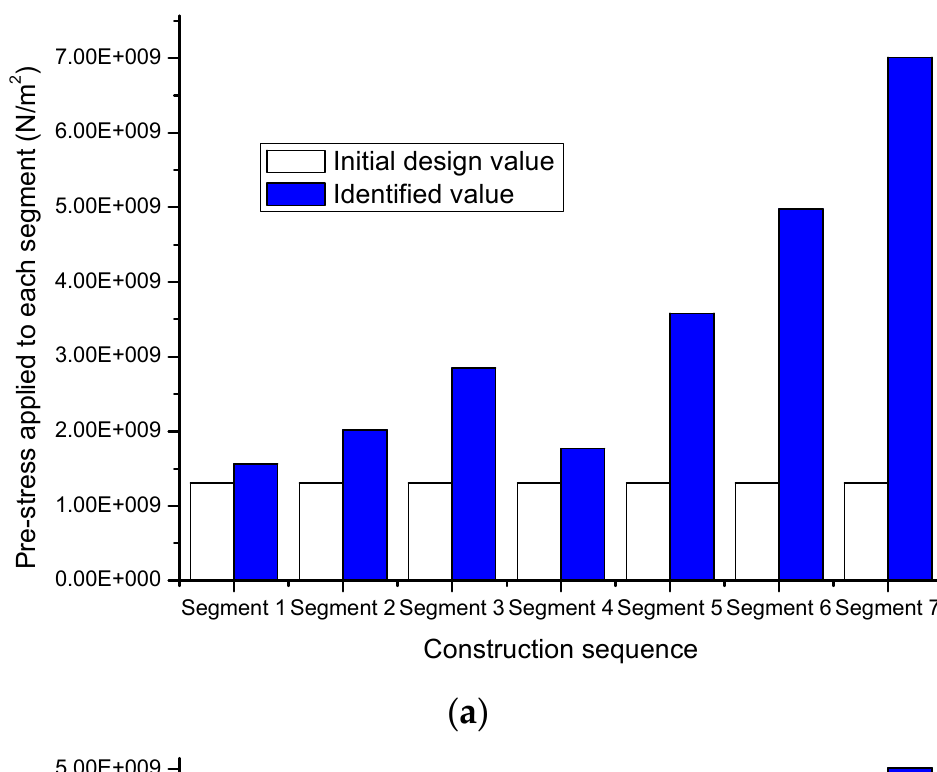
Figure 11. Design pre ‐ stresses applied to segments 1~7 and the identified values. ( a ) #6 pier; ( b ) #7 pier.